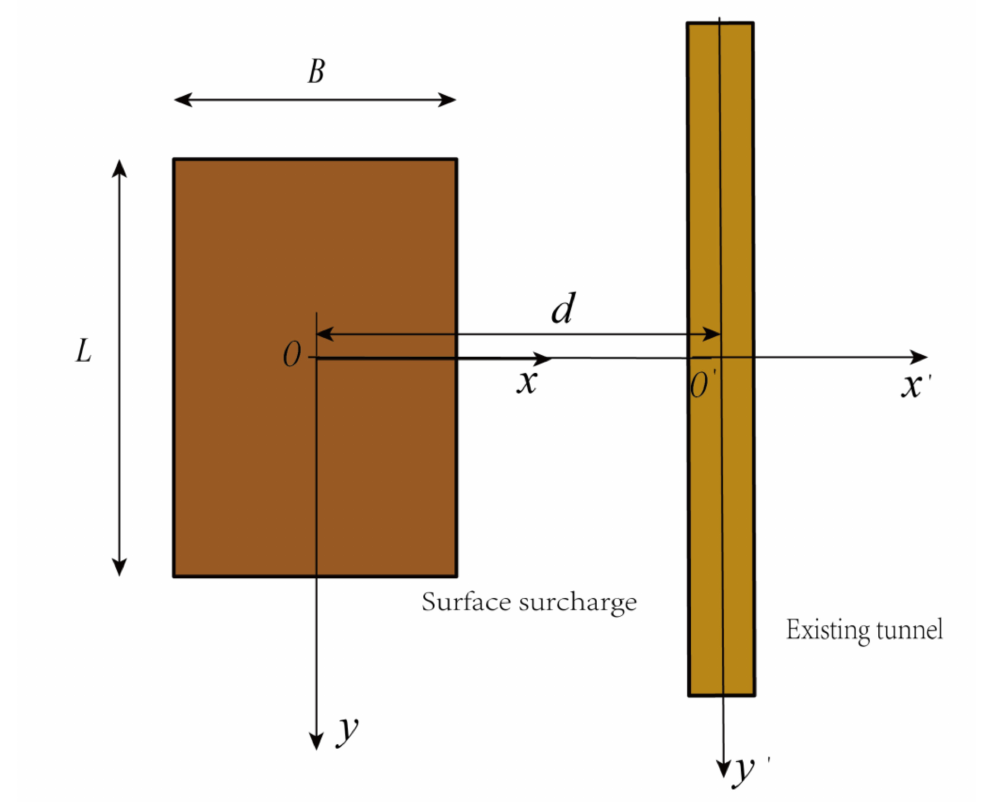
Figure 12. Relative positions of the tunnel and surface